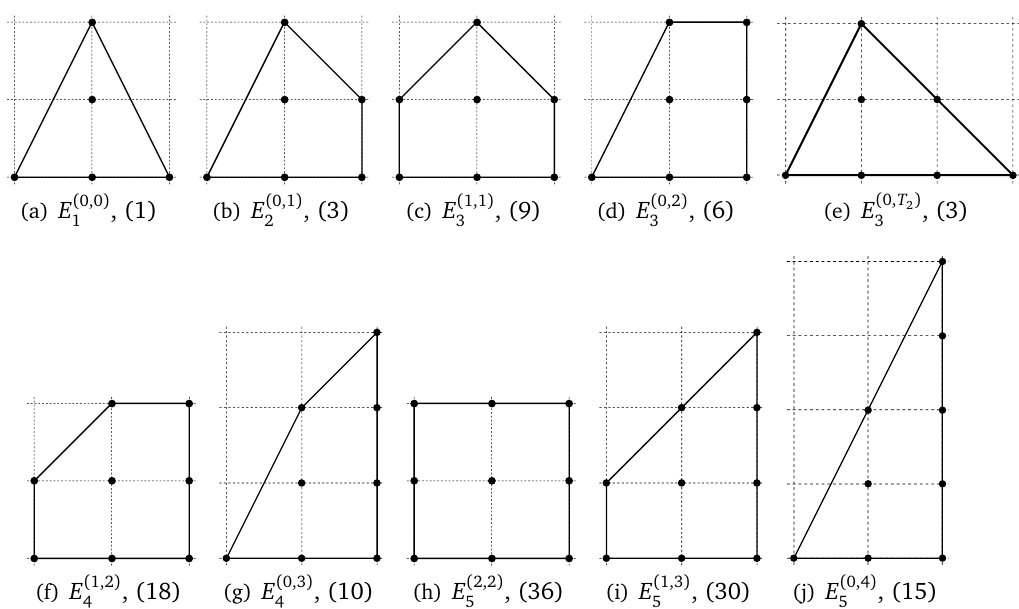
Figure 26: 10 of the 11 non-isolated “rank-one” toric singularities. The number in parenthesis is the number of triangulations with an allowed vertical